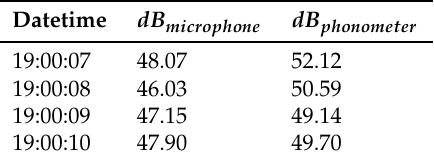
Table 1. Comparison of dB SPL measured by the microphone and the sound level